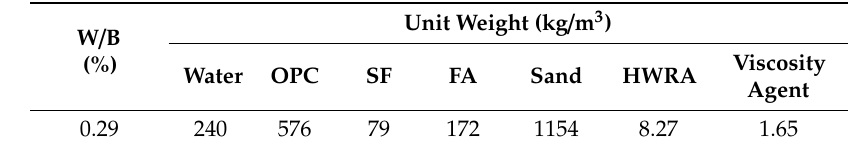
Table 2. Mixture